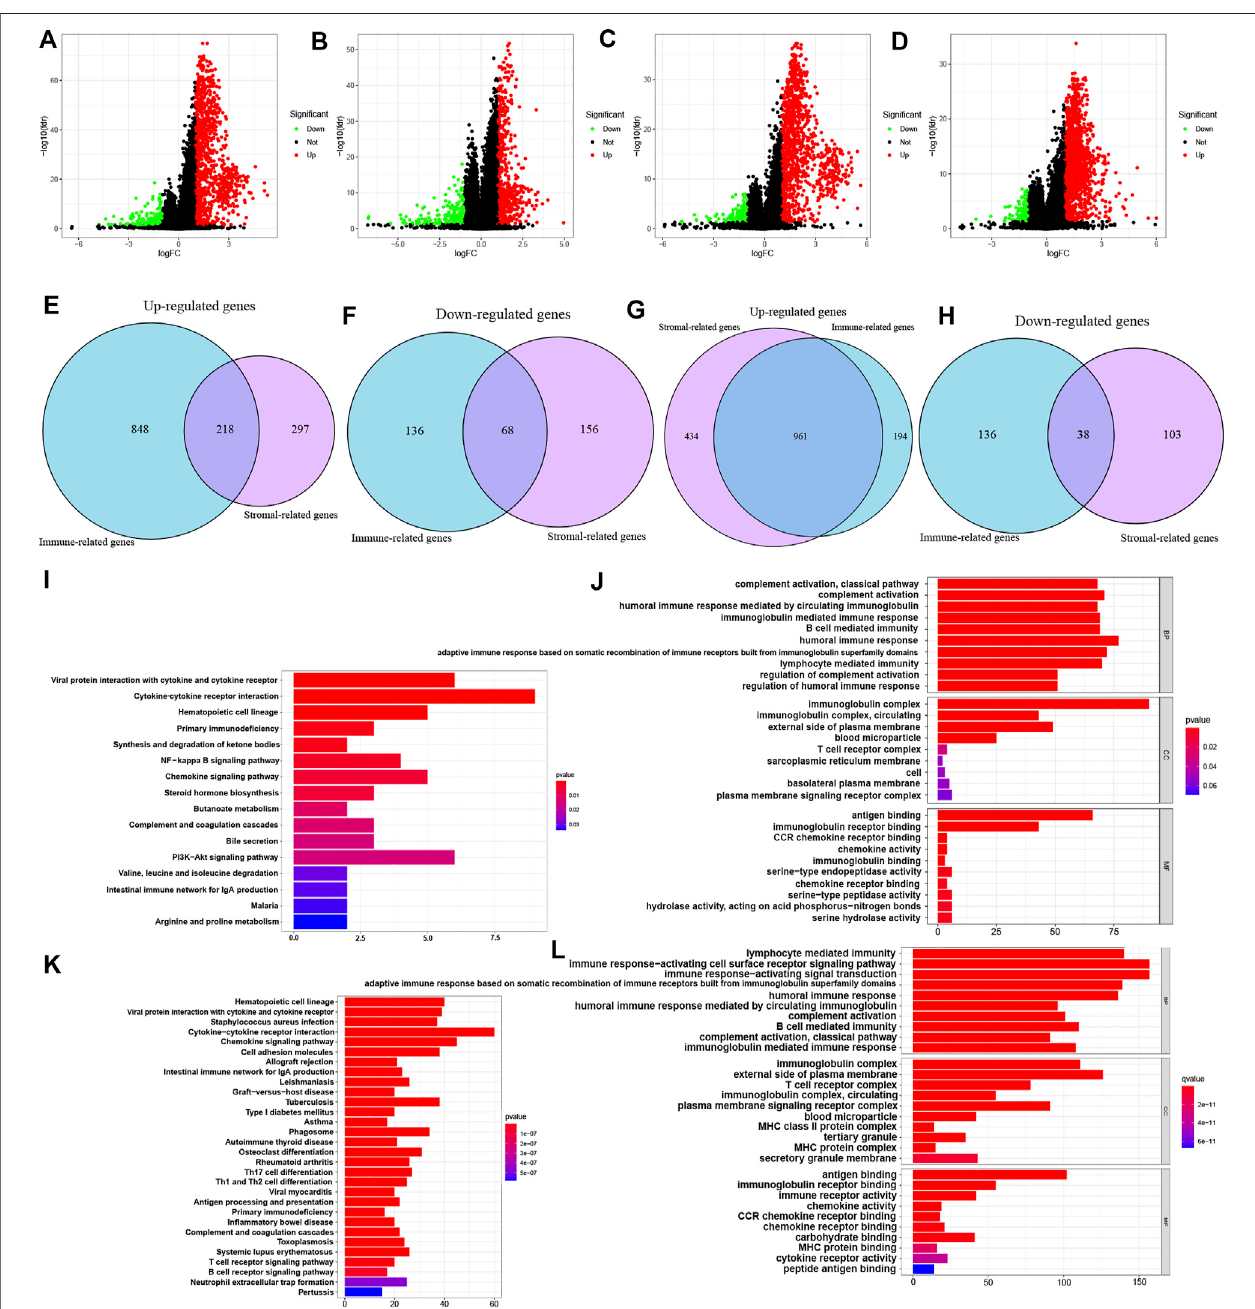
FIGURE2| Identi fi cationofDEGsbasedonESTIMATEscoresandfunctionalanalysisofcommonDEGs. (A-D) VolcanoplotofDEGsfromtheimmunescoresand stromal score groups in ccRCC (A-B) and pRCC (C-D) . (E-H) Commonly changed genes in immune scores and stromal scores groups in ccRCC (E-F) and pRCC (G-H) . (I-L) KEGG and GO enrichment analysis in ccRCC (I-J) and pRCC (K-L) .